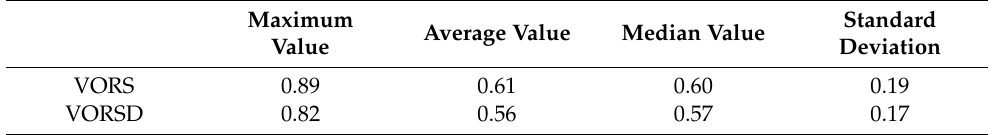
Table 2. Comparison of the results of ecosystem health calculations between the two